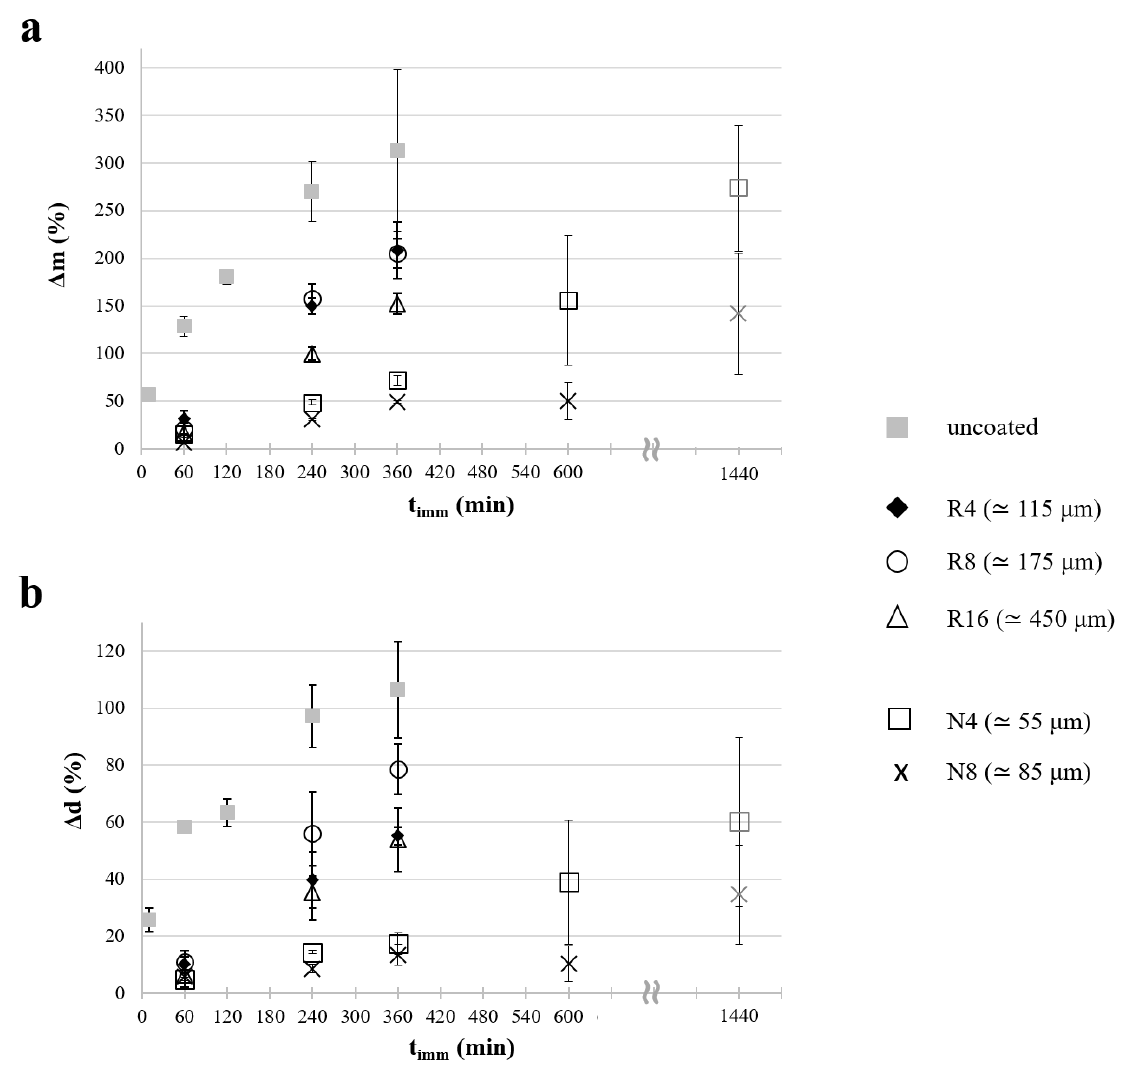
Figure 7. Profiles of ( a ) mass variation and ( b ) diameter increase plotted versus immersion time relevant to uncoated and coated samples.